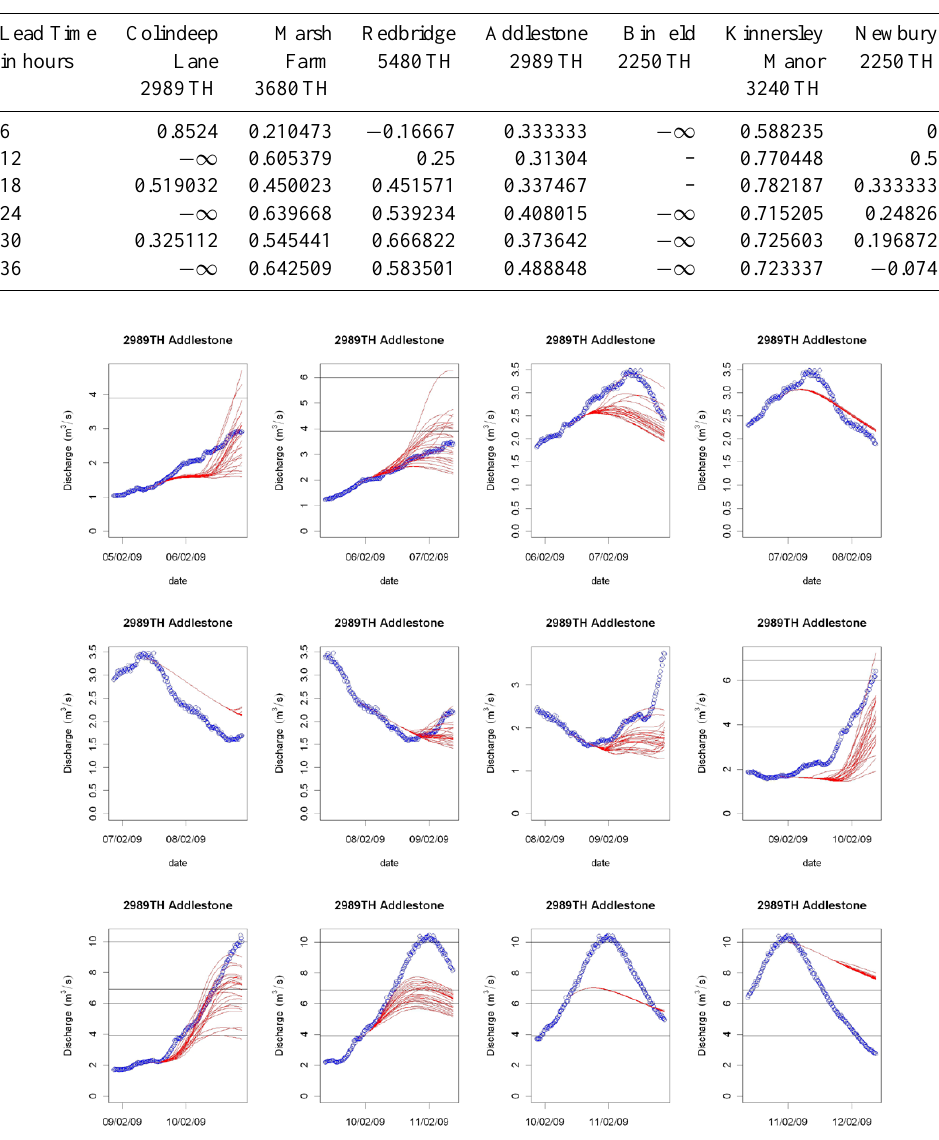
Table 3. Mean RPSS for the period July 2008 to February 2009 using the thresholds of Table 1 and the na¨ıve forecast (persistence) as reference forecast.